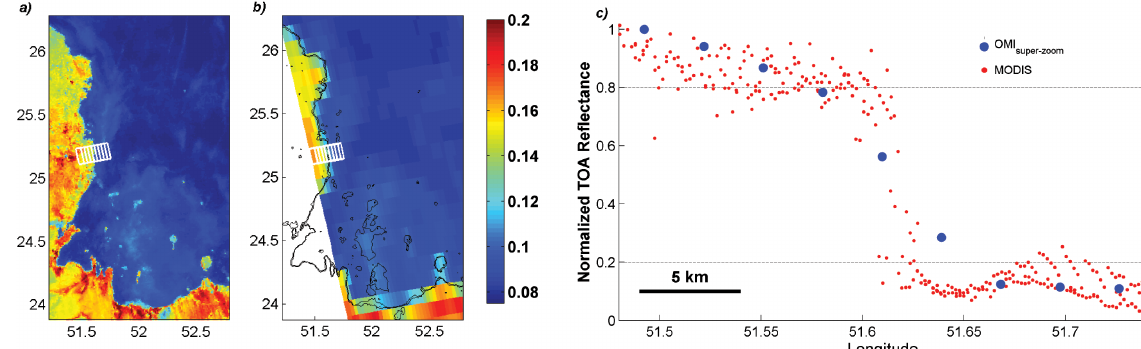
Fig. 1. Top-of-atmosphere reflectance (459–479nm) observed by (a) MODIS and (b) the super-zoom mode of OMI over Qatar on 19 Novem- ber 2004. (c) Normalized top-of-atmosphere reflectance observed by MODIS (red) and OMI (blue) along a transect perpendicular to the Qatari coastline – white boxes, (a–b)